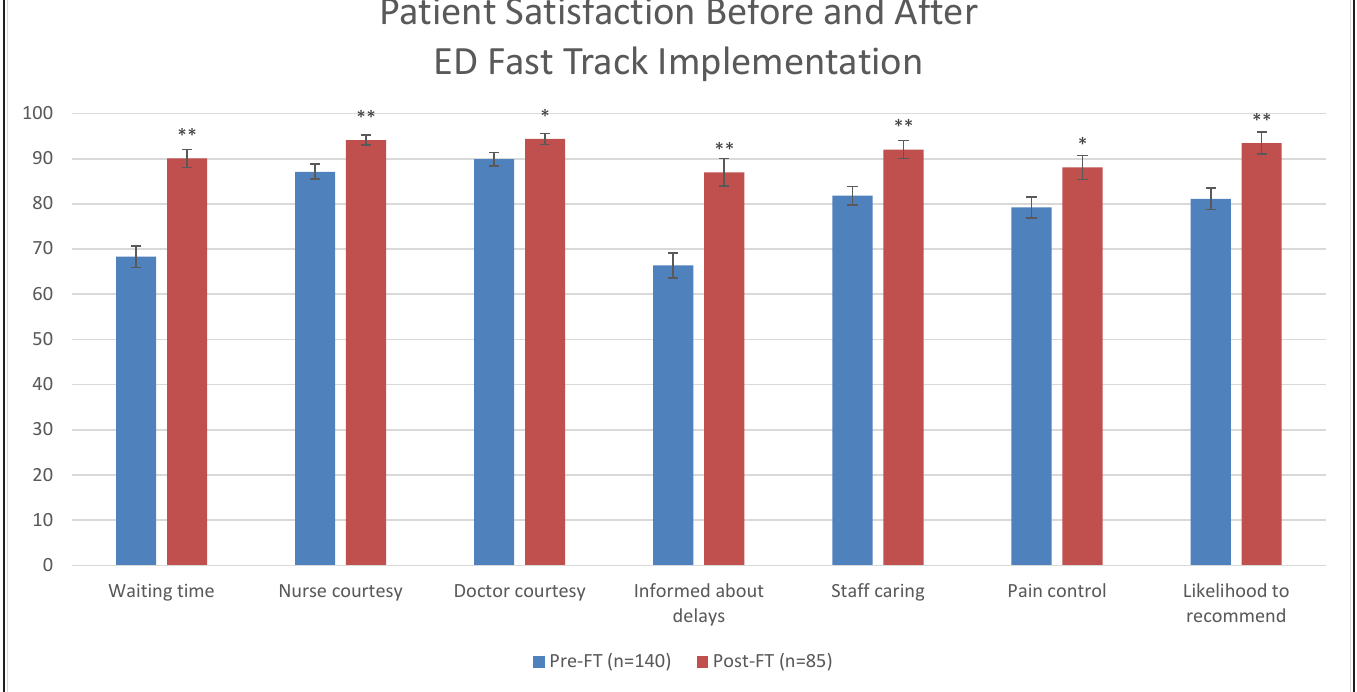
Figure 1. Comparison of patient satisfaction scores before and after implementation of ED Fast